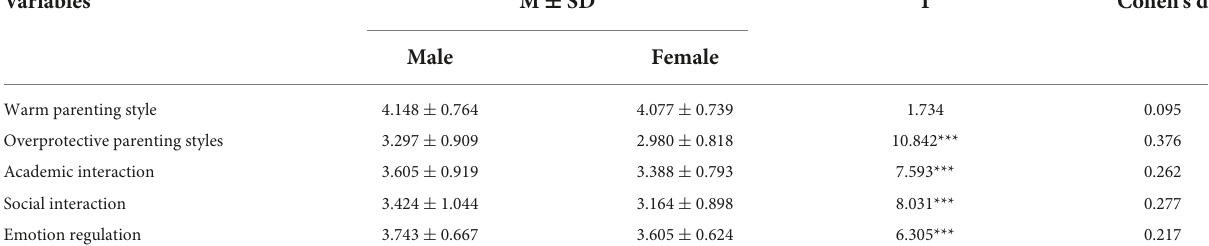
TABLE 4 Tests for differences in key variables by gender.